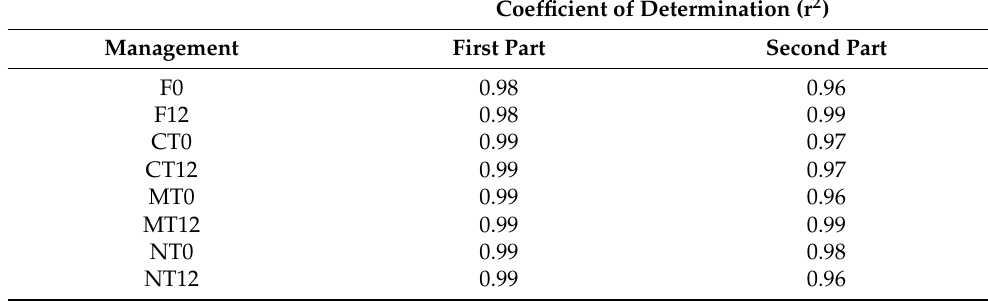
Table 1. Values of the coefficient of determination (r 2 ) of the linear adjustments for the two parts (first and second) of the 3D lacunarity ( Λ ) curves for the areas under secondary forest (F) and the three management practices (conventional tillage—CT, minimum tillage—MT, and no tillage—NT) submitted to 0 and 12 wetting and drying (W-D) cycles.